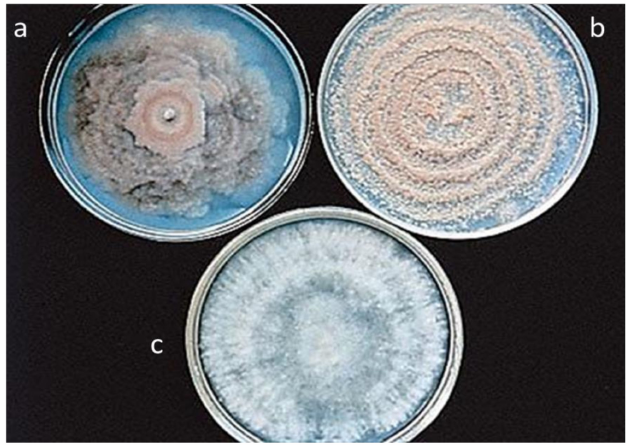
Figure 6. Pure cultures on potato dextrose agar (PDA) showing the morphologies of the three major species of Monilinia at 10 days (22 ◦ C) of incubation: ( a ) M. laxa , ( b ) M. fructicola , and ( c ) M. fructigena . (Photograph Courtesy APS Press). Reproduced with permission from Compendium of Stone Fruit Diseases, 1995, American Phytopathological Society, St. Paul, MN, USA.). https://www.apsnet.org/ edcenter/intropp/lessons/fungi/ascomycetes/Pages/BrownRotStoneFruits.aspx